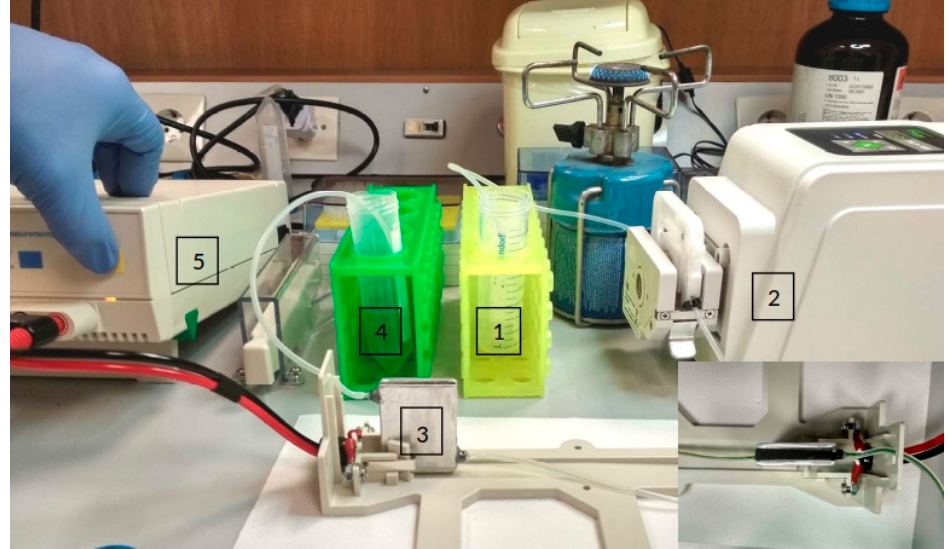
Figure 3. Microalgae cells and the magnetic nanoparticles are contained in the testing tube (1). From there, the peristaltic pump (2) pulls the mixture and drives it through the electroporator device (3). Then, the mixture ends up in collector tube (4). The electric generator is controlled manually (5). On the right bottom corner is a top view of the electroporator device at the base of the Bio-Rad